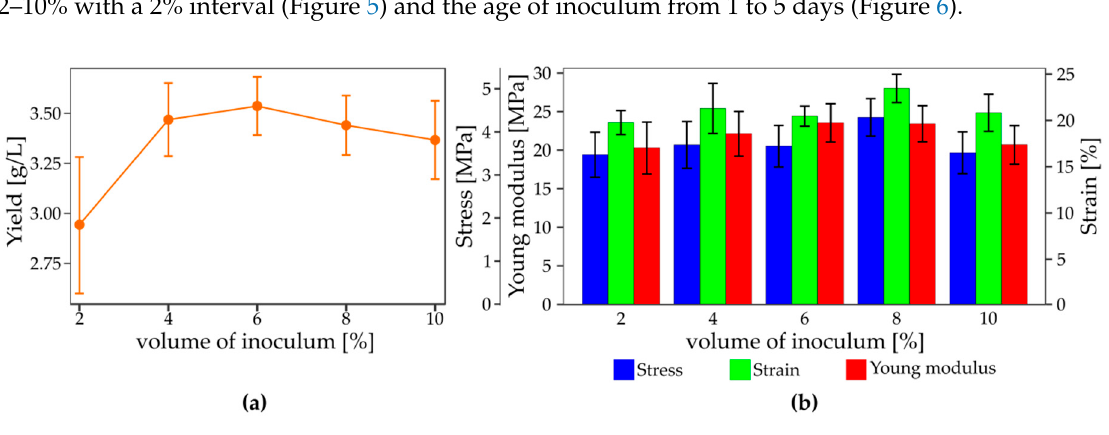
Figure 5. Impact of inoculum volume on ( a ) biosynthesis yield and ( b ) tensile parameters of bacterial nanocellulose.